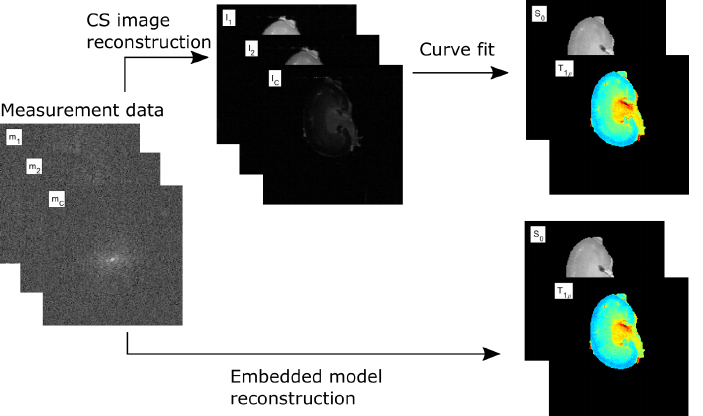
Figure 1. Schematic of the two-step CS T 1 ρ mapping method and the embedded, direct T 1 ρ map- ping